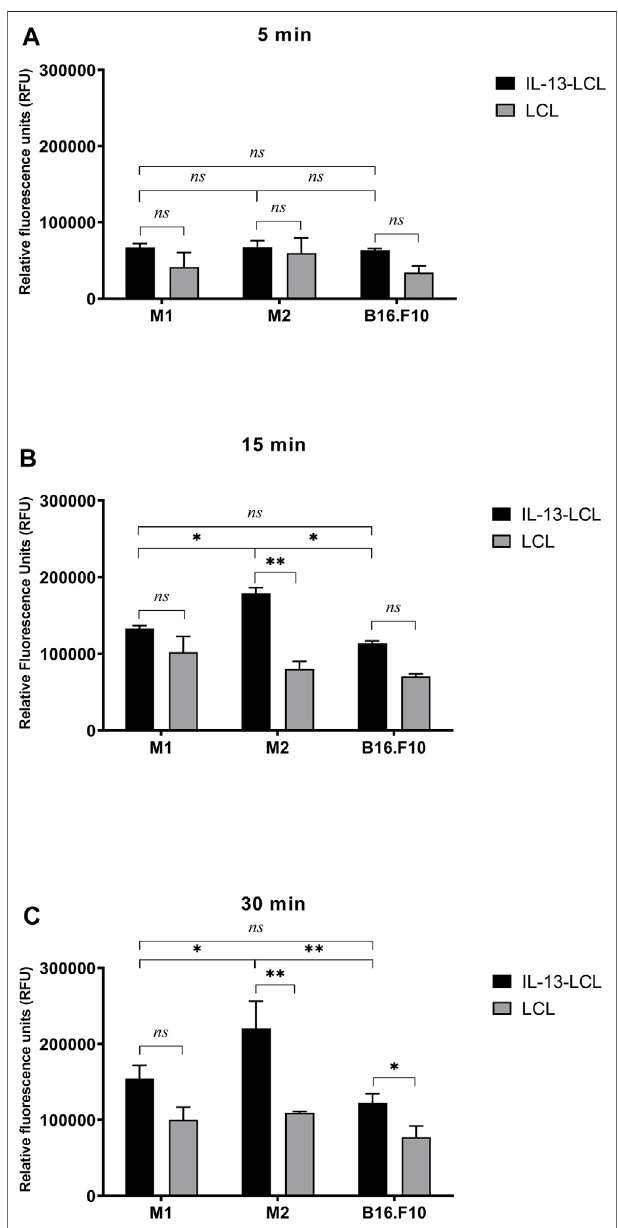
FIGURE 1 | Spectro fl uorimetric assessment of IL-13 functionalized LCL uptake by M1/M2 macrophages and B16.F10 cells compared to unconjugated LCLuptake.Uptakemeasurementswereperformedafter5 (A) ,15 (B) ,and30 (C) min incubation of all cell types with a concentration of 20 mM (LCL) and 11 mM (IL-13-LCL) phospholipids containing the fl uorescent component rhodamine.Resultswereexpressedasmean±SDoftriplicatemeasurementsand shown as Relative Fluorescence Units (RFUs). Untreated M1/M2 polarized macrophages and B16.F10 cells were used to remove background cell auto fl uorescence. The unpaired t-test was used to compare the uptake of IL-13- LCL and LCL in M1/M2 macrophages and B16.F10 melanoma cells; ns — not signi fi cant; p > 0.05; *, p < 0.05; and **, p <